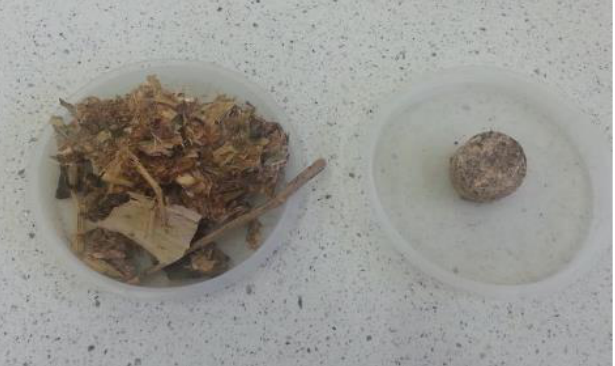
Figure 1. Material before and after the agglomeration process.